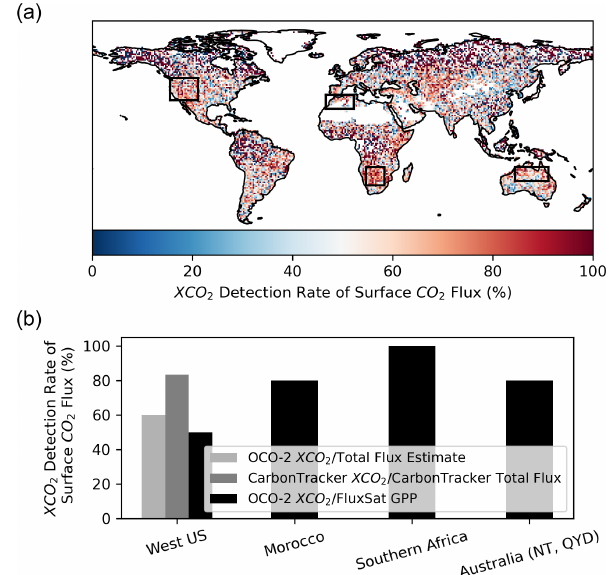
Figure 8. OCO-2 XCO 2 anomalies alone can detect extreme CO 2 flux anomalies. OCO-2 detection rate of extreme surface CO 2 flux anomalies (or positive XCO 2 anomalies when surface CO 2 efflux anomalies are the largest) (a) across the globe in each pixel and (b) within specific regions. The legend in (b) shows the datasets used to estimate the detection rate including pairs of OCO-2 XCO 2 anomalies and total CO 2 flux anomaly estimates from LPJ and QFED, pairs of CarbonTracker XCO 2 anomalies and Carbon- Tracker total CO 2 flux anomaly estimates, and pairs of OCO-2 XCO 2 anomalies and photosynthesis flux anomaly estimates from FluxSat GPP.